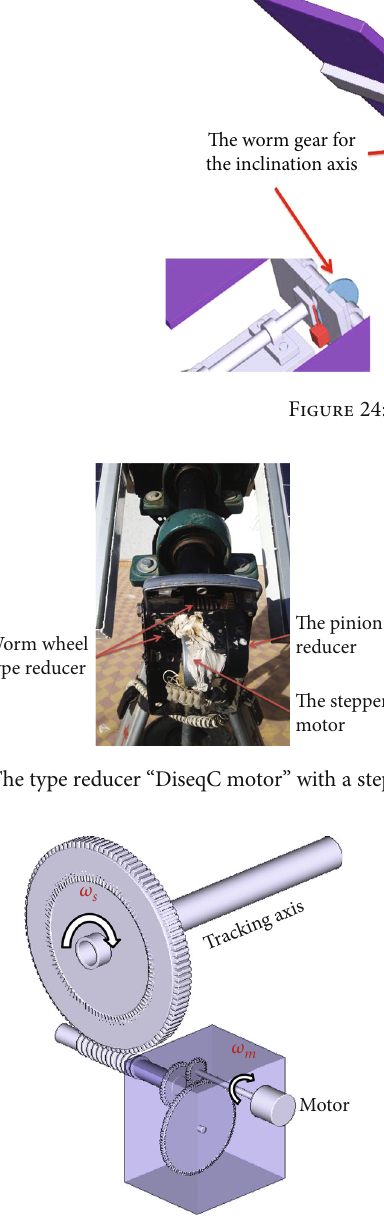
Figure 26: The rotation speed of the tracking motor.